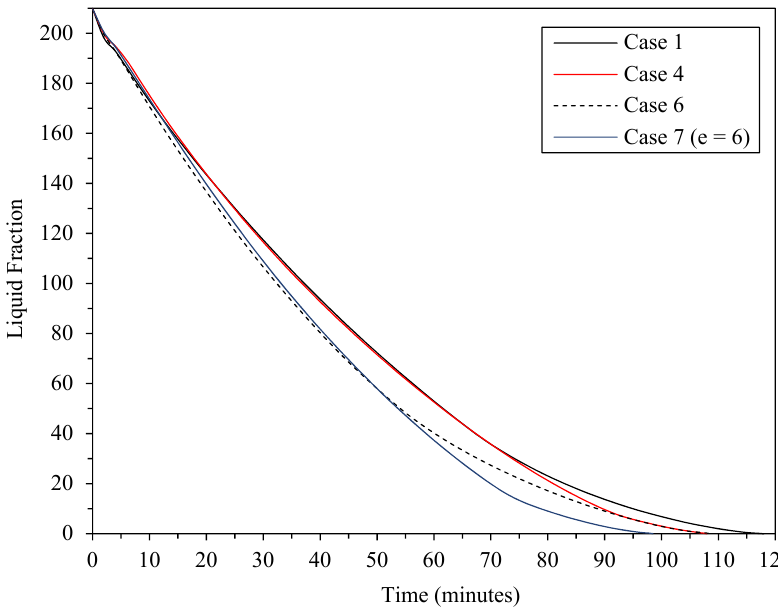
Figure 11. Comparison of transient liquid fraction between some selected cases.